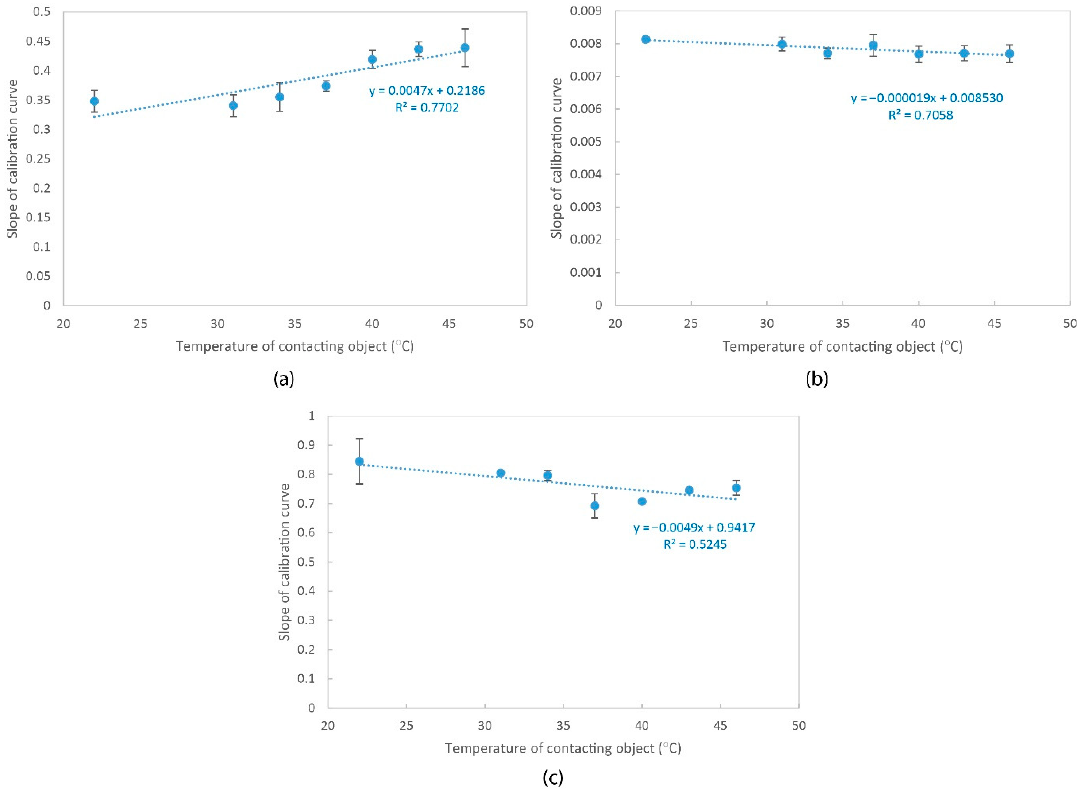
Figure 8. Correlation between slope of calibration curve and temperature of contacting object for ( a ) FlexiForce sensor, ( b ) SingleTact sensor, and ( c ) Pliance X sensor.